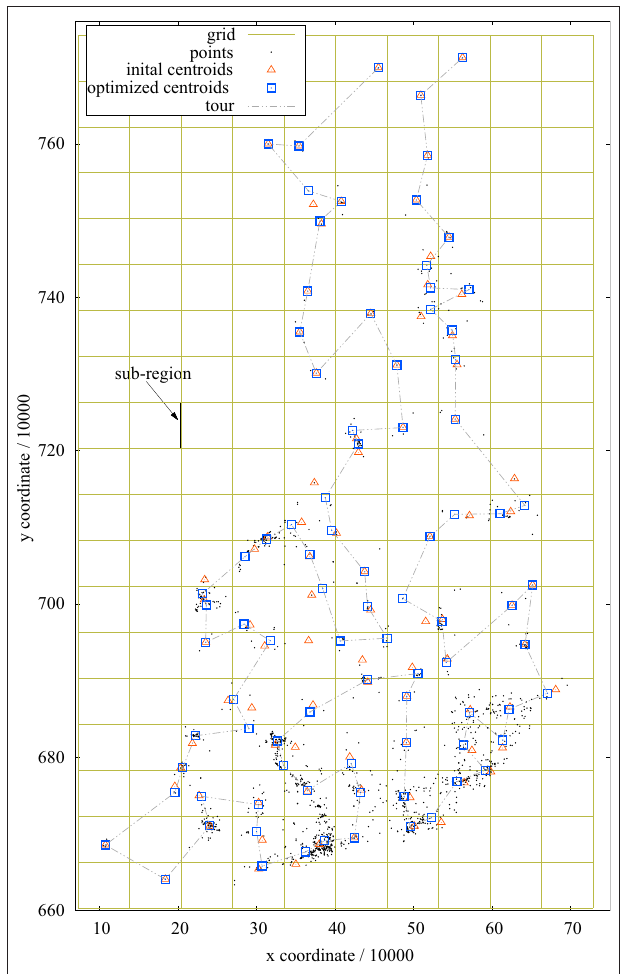
FIGURE 2 | Example of sub-regions, cluster centroids, and coarse tour for a 1,437-points problem. Red triangles mark the centroids of the sub-regions; blue squares indicate the cluster centroids after new